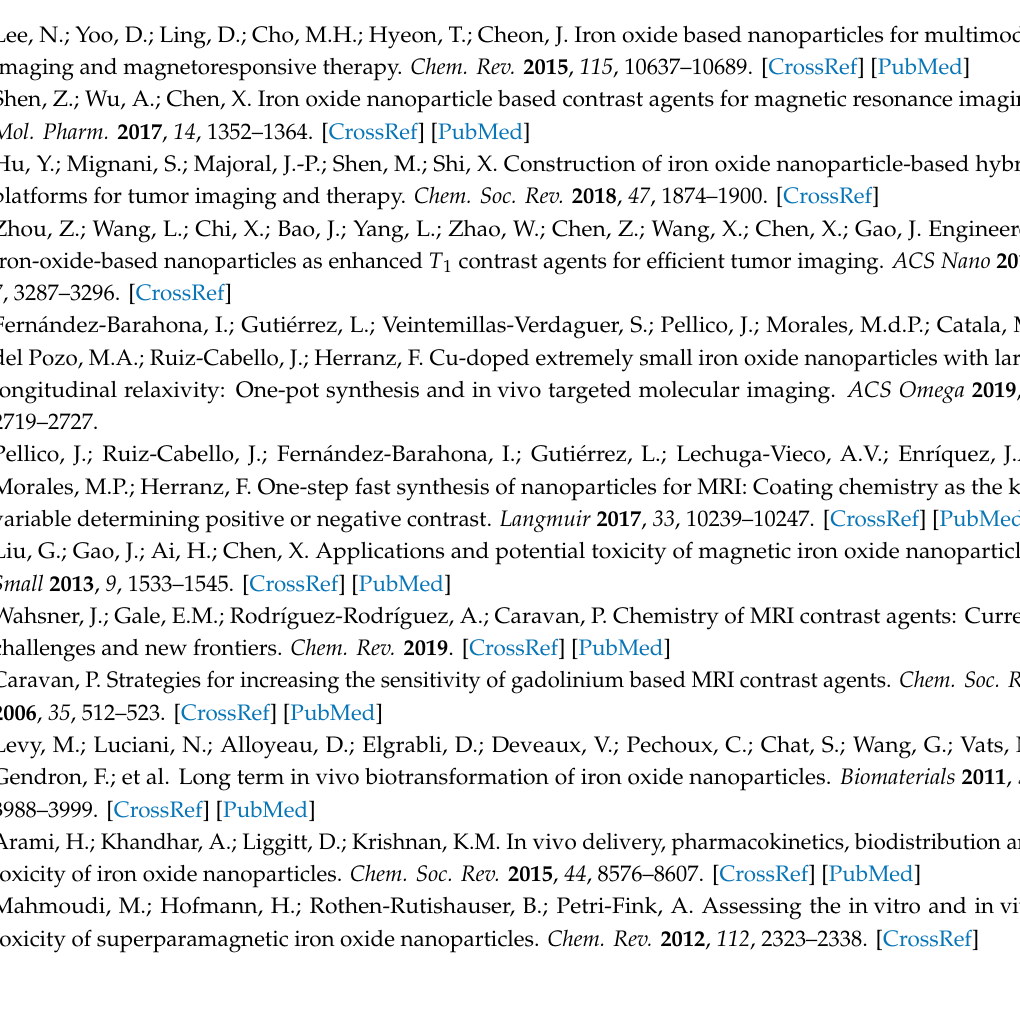
Figure S1: Particle size distribution of (a) Fe 3 O 4 -PAA, (b) Fe 3 O 4 -PAH and (c) Fe 3 O 4 -PVA acquired from the TEM images. Figure S2: The hydrodynamic size profile of (a) Fe 3 O 4 -PAA, (b) Fe 3 O 4 -PAH and (c) Fe 3 O 4 -PVA nanoparticles in aqueous